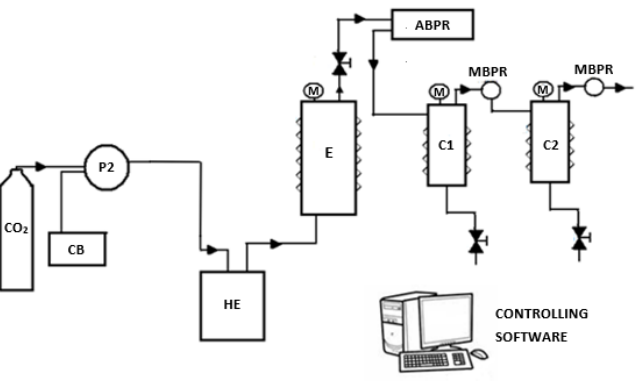
Figure 5. Scheme of the laboratory scale pilot plant. CO 2 reservoir (R), cooling bath (CB), CO 2 pump (P), heat exchanger (HE), extractor (E), collector 1 (C1), collector 2 (C2), automatic back pressure regulator (ABPR), manual back pressure regulator (MBPR), temperature and pressure gauges (M).